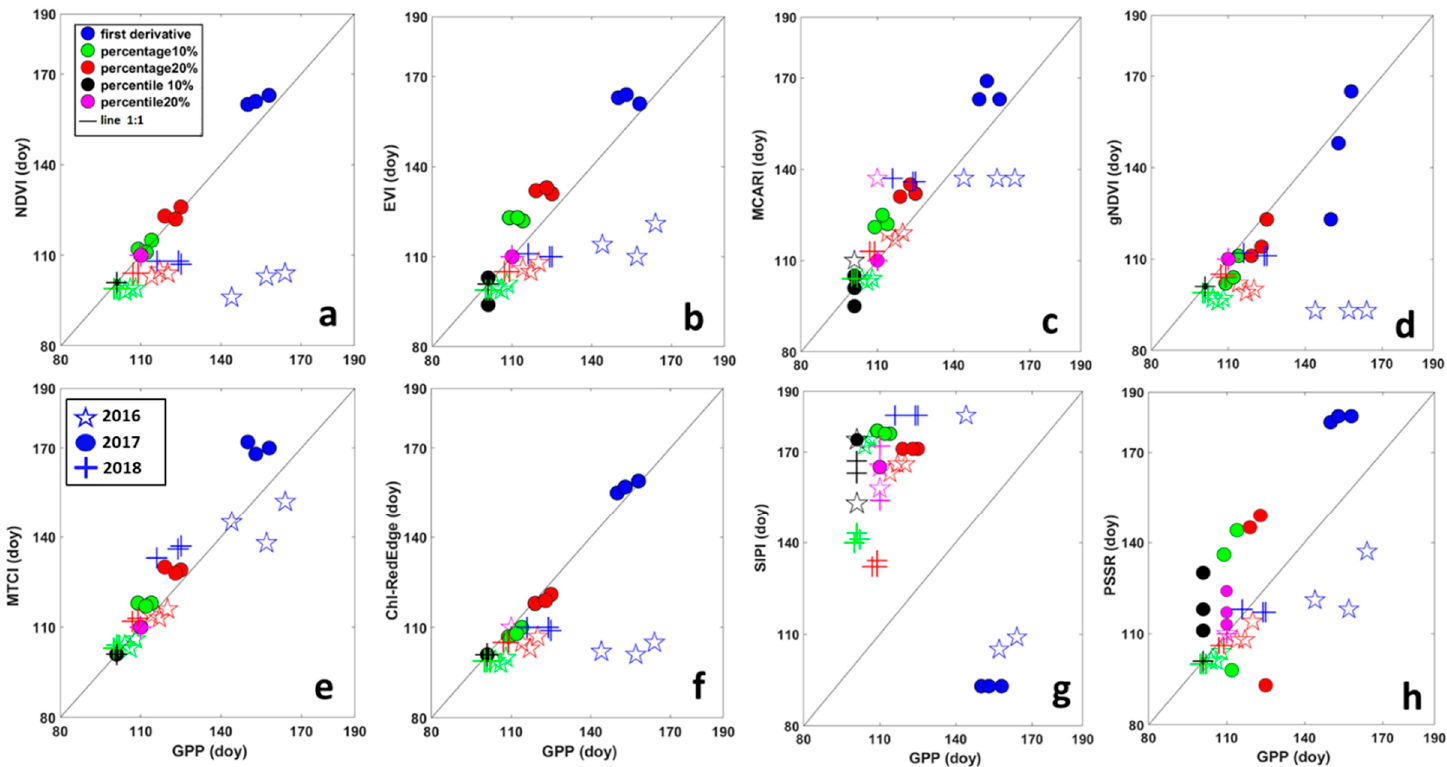
Figure 4. Relationship between the start of the season (SOS), in days, derived from Gross Primary Productivity (GPP) and different vegetation indices. ( a ) NDVI—Normalized Difference Vegetation Index; ( b ) EVI—Enhanced Vegetation Index; ( c ) MCARI—Modified Chlorophyll Absorption Ratio Index; ( d ) gNDVI—Green Normalized Difference Vegetation Index; ( e ) MTCI—MERIS Terrestrial Chlorophyll Index; ( f ) ChlRedEdge—Chlorophyll red-edge; ( g ) SIPI—Structure Insensitive Pigment Index; and ( h ) PSSR—Pigment Specific Simple Ratio. Different colors represent different methods for deriving SOS: blue = first derivative method; green = percentage 10%; red = percentage 20%; black = percentile 10%; pink = percentile 20%. Symbols show different years: stars ( ) are for 2016; circles ( ● ) for 2017 and plus ( + ) for 2018.